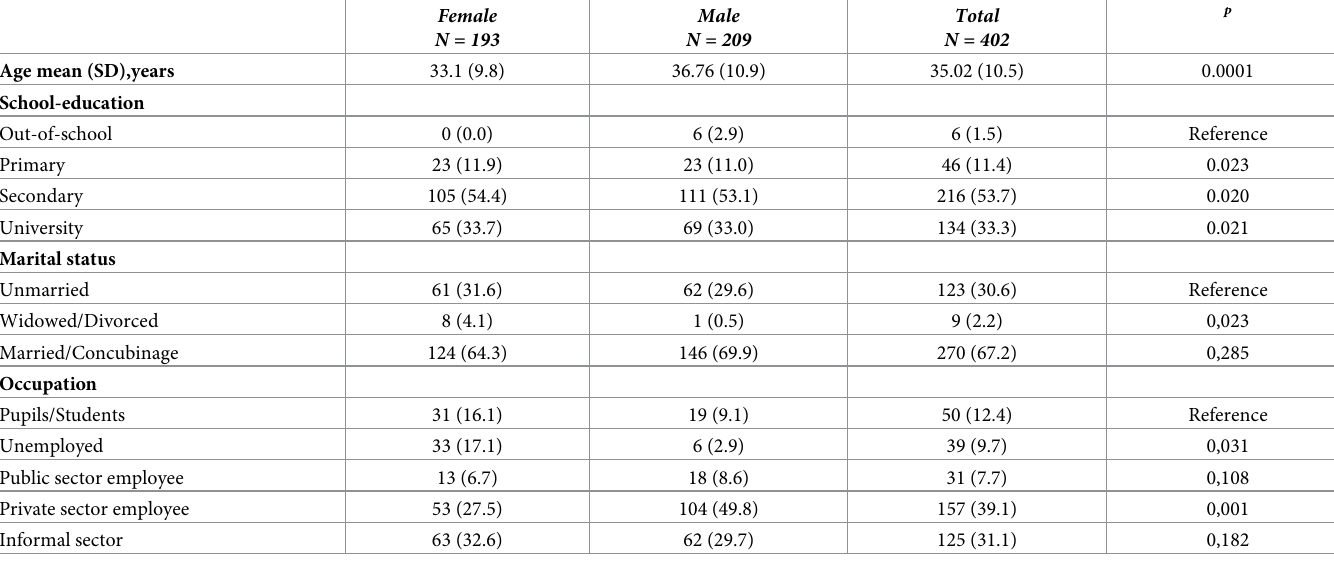
Table 1. Characteristics by gender of participants visiting the pharmacies to purchase